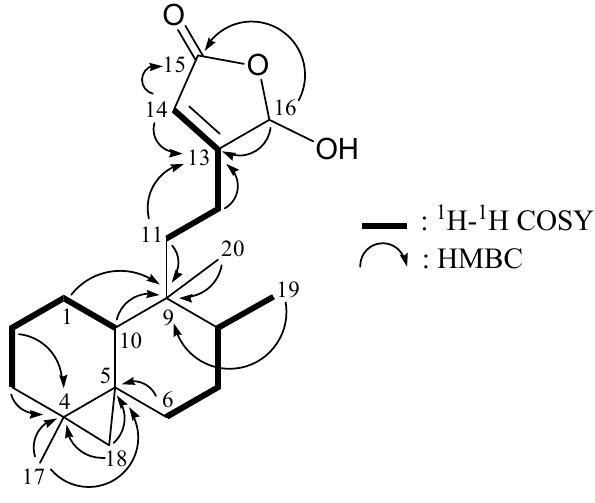
Figure 2. The 1 H– 1 H COSY and selective key HMBC (protons → quaternary carbons) correlations for 1